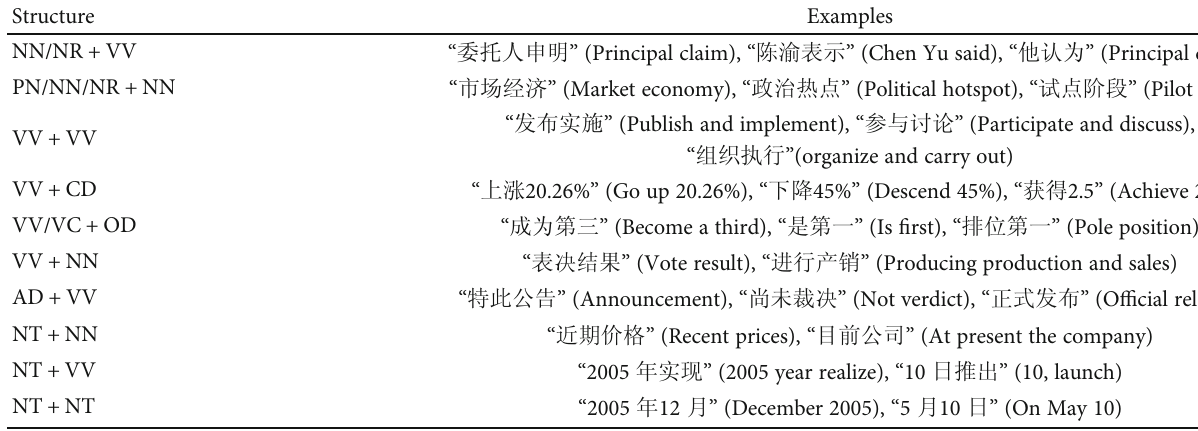
Table 10: News 2-gram list (part).